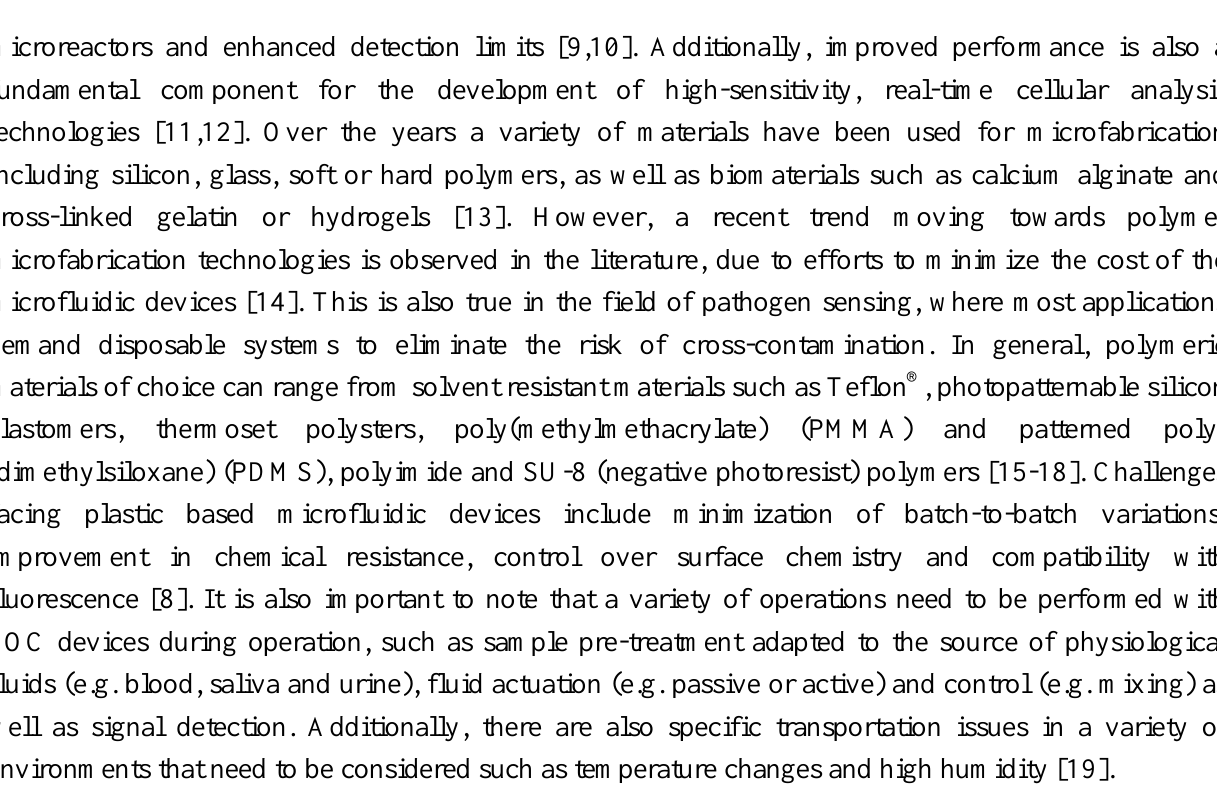
Figure 1. Schematic overview of microfluidic based pathogen sensing